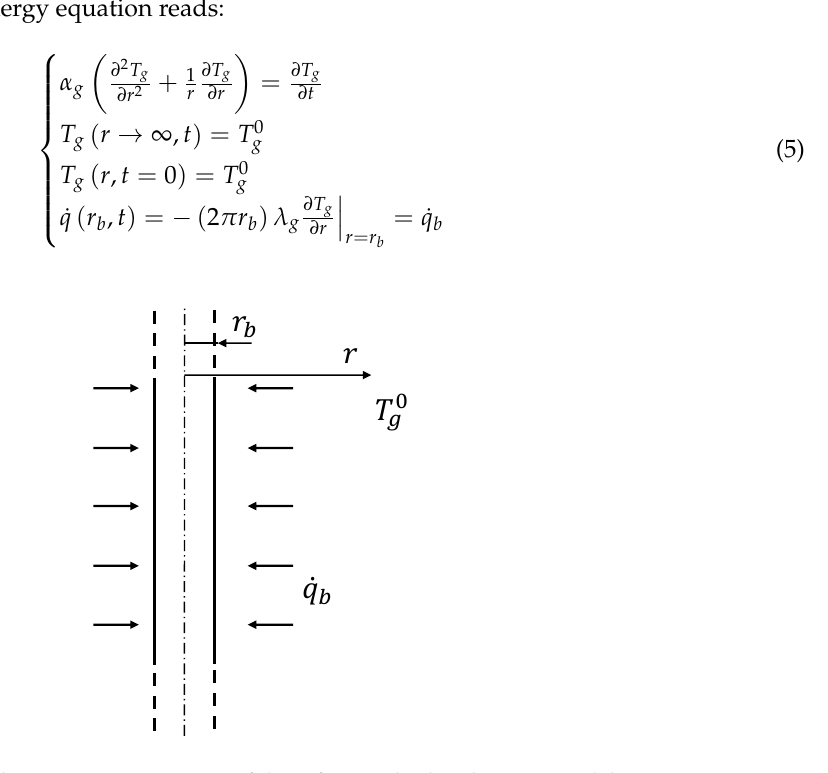
Figure 3. Schematic representation of the infinite cylindrical source